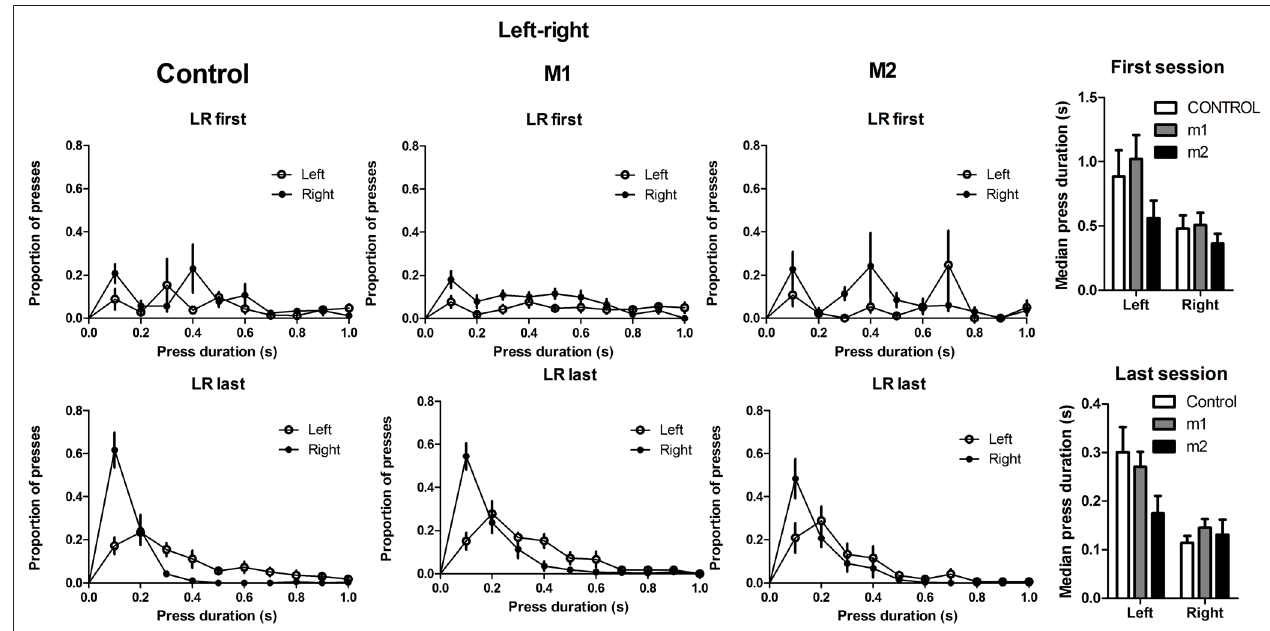
FIgure 8 | Lever press duration distributions of the first and second actions during the acquisition of the